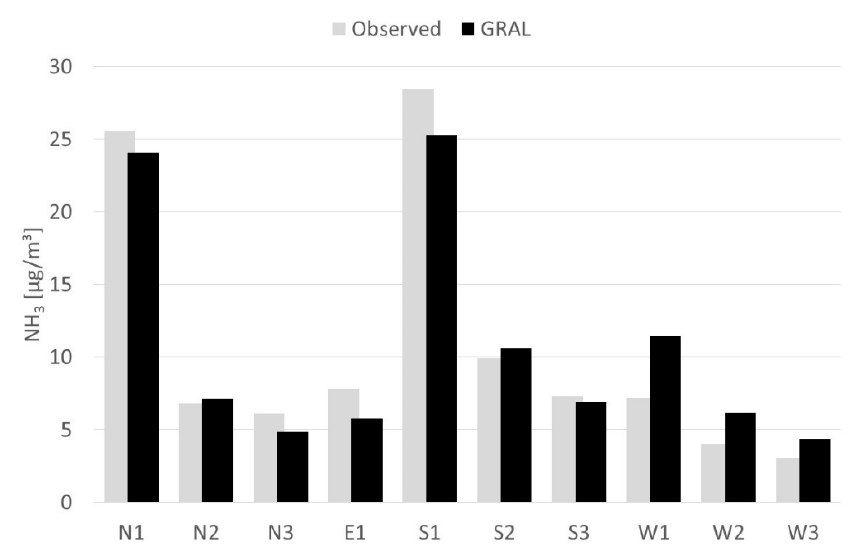
Figure 7. Comparison of observed and modelled ammonia concentrations for each sampling point averaged over the period from January to November 2021.